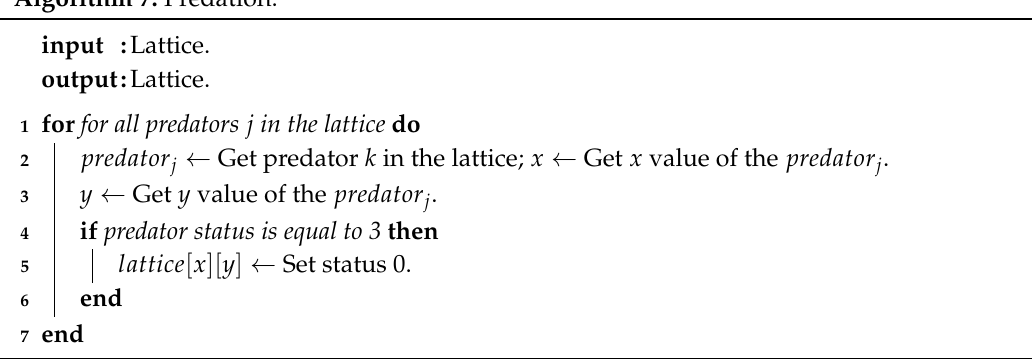
Algorithm 7: Predation.